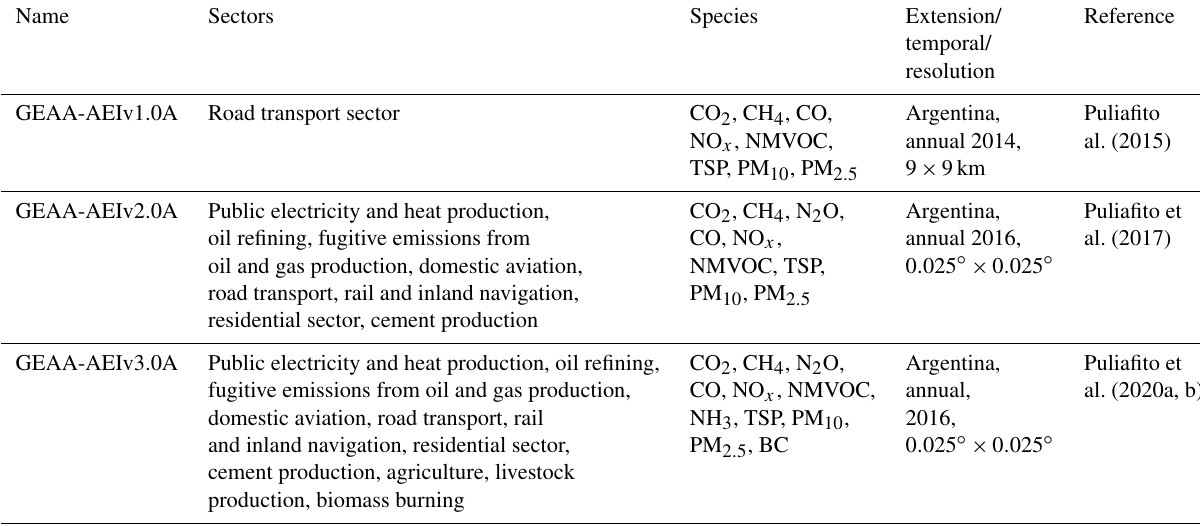
Table A1. Argentine inventories developed at the Group for Atmospheric and Environmental Studies (GEAA).